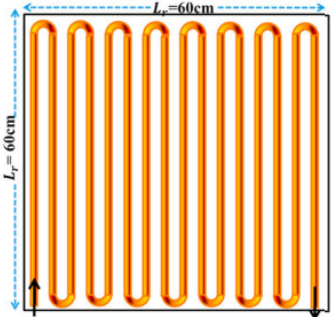
Figure 22. Schematic view of a heat recovery coil circuit with marked PV cells [108].